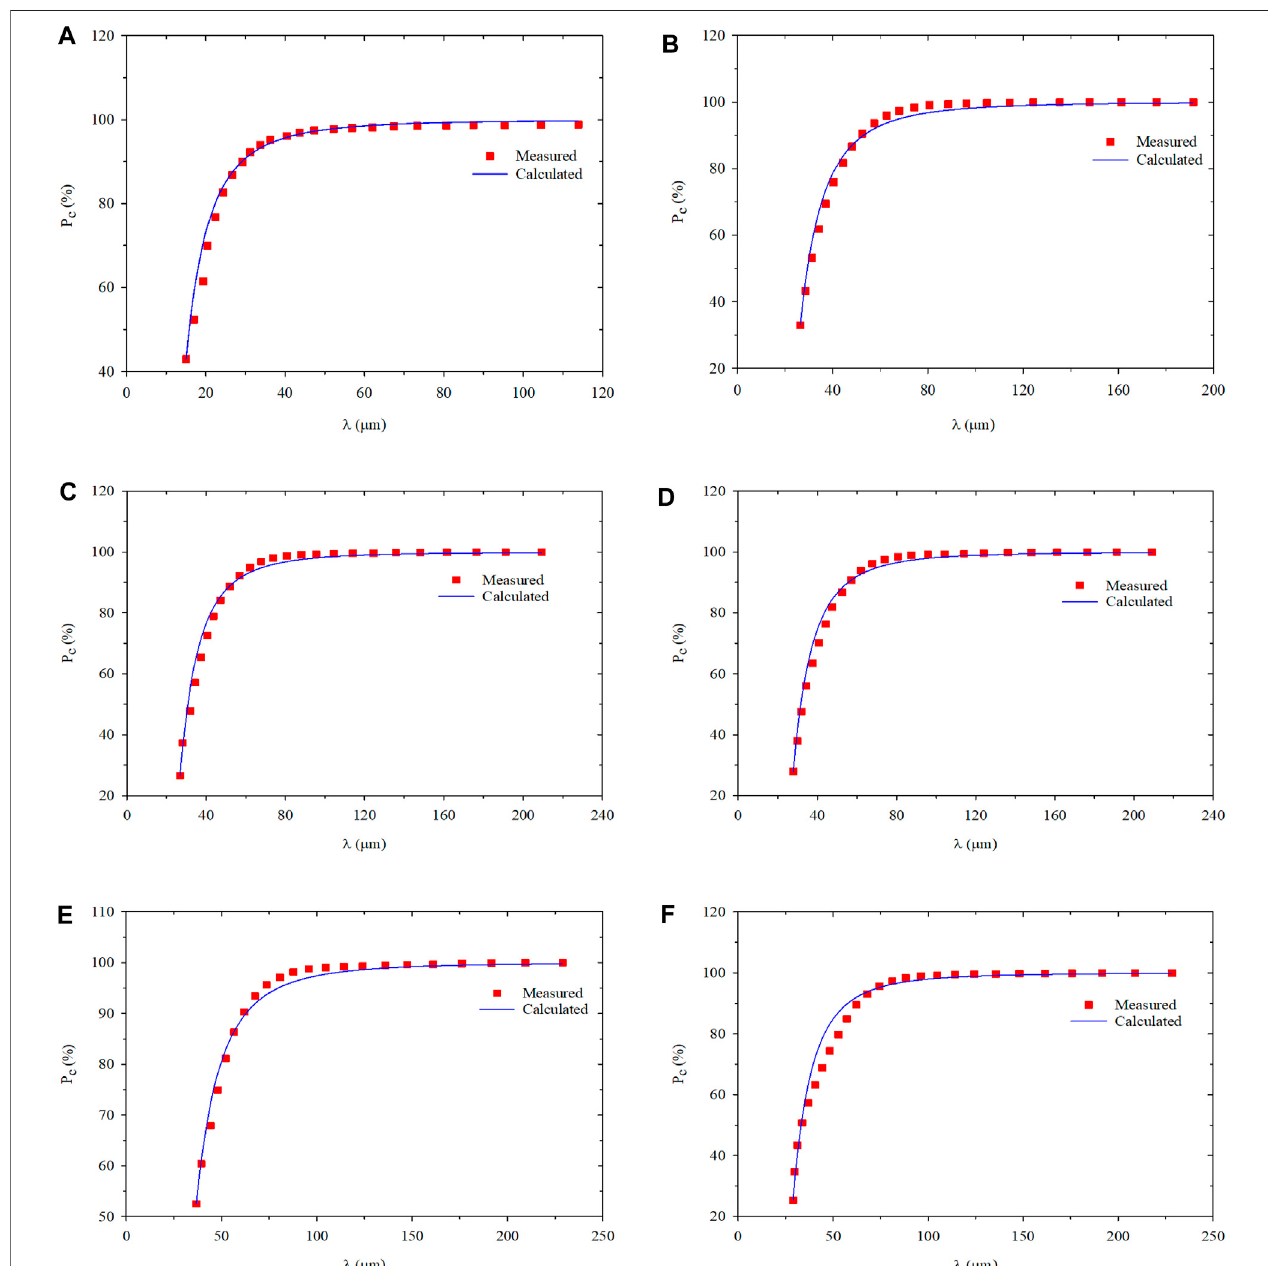
FIGURE5| ComparisonofsizedistributionwithcumulativeprobabilitymethodofPMsatthedifferenthydrationtime: (A) Hydrationinitialstate; (B) Hydrationtime1 day; (C) Hydration time 3 days; (D) Hydration time 5 days; (E) Hydration time 10 days; (F) Hydration time 30 days.